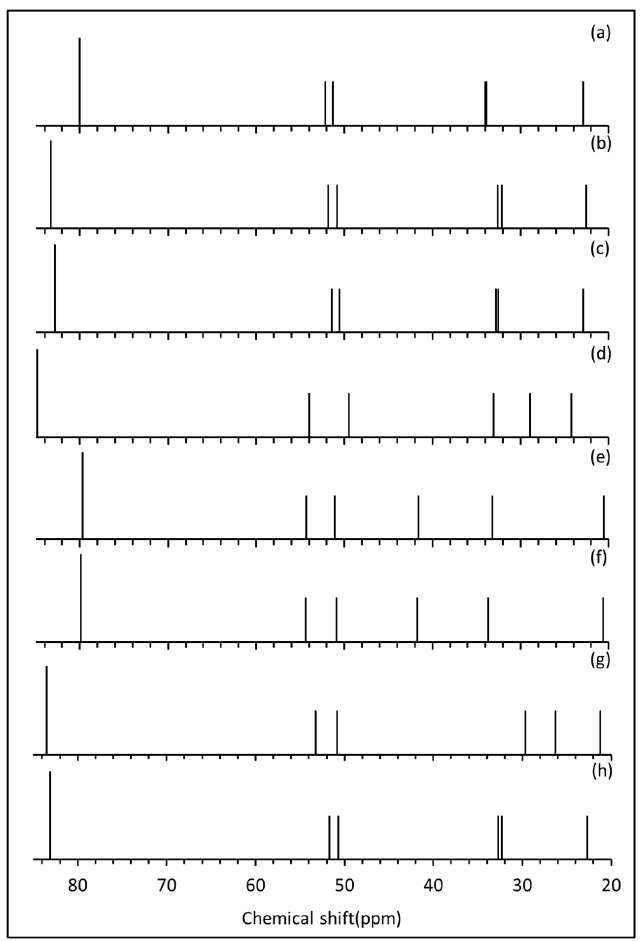
Figure 4. The experimental and simulated spectra of the 6 potential input geometries. ( a ) Experiment; ( b ) saa - aa ; ( c ) saa - sa ; ( d ) saa - as ; ( e ) aaa - aa ; ( f ) aaa - sa; ( g ) sas - aa. Only the saa-aa and eaa-sa conformers have simulated spectra that resemble the experimental spectrum, with saa-sa being slightly the closer. ( h ) A 60:40 weighted average of ( b , c ), as discussed in Section